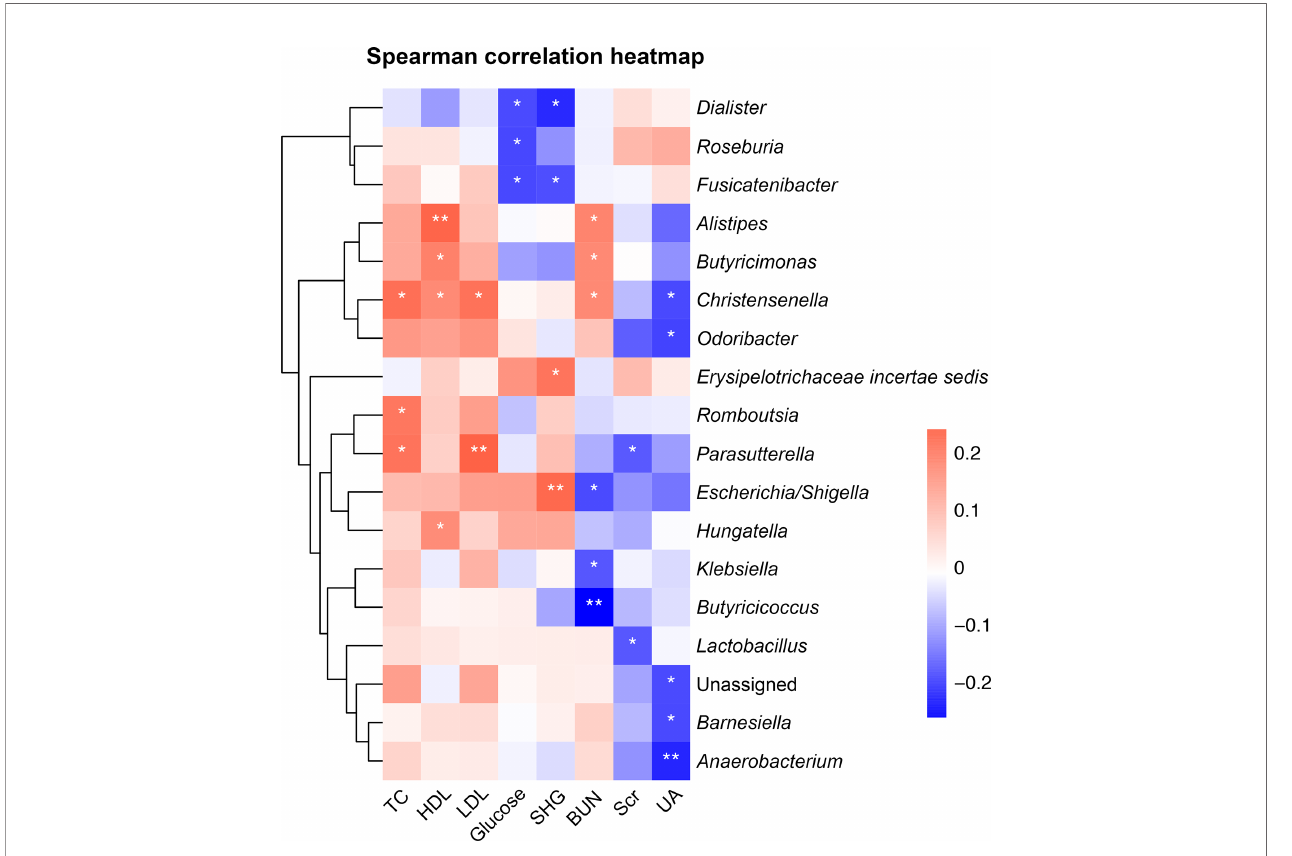
FIGURE 4 | Heatmap of Spearman correlation analysis between gut microbiota and biochemical parameters. * p < 0.05, ** p < 0.01. TC, total cholesterol; HDL, high- density lipoprotein cholesterol; LDL, low-density lipoprotein cholesterol; SHG, stress hyperglycemia; BUN, blood urea nitrogen; Scr, serum creatinine; UA, uric